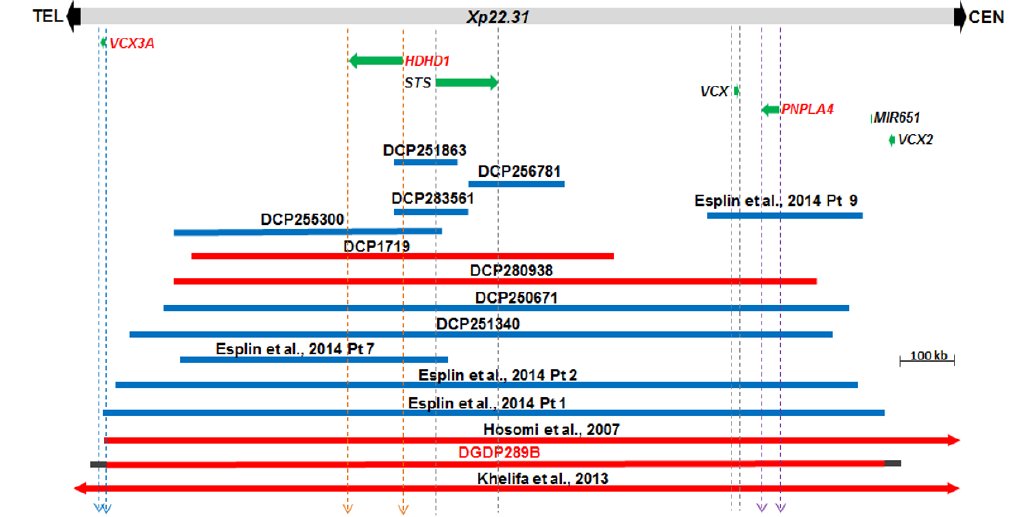
Figure 3. Comparative deletion mapping of CNVs at Xp22.31. The genes proximal and distal to STS are displayed. The microdeletion in our patient DGDP289B encompasses at least HDHD1 , STS , VCX , PNPLA4 and MIR651 . The distal breakpoint lies either within or in the immediate telomeric vicinity of VCX3A , while the proximal breakpoint resides around VCX2 . Three candidate genes, VCX3A , HDHD1 , and PNPLA4 , are in red letters. A total of eight additional cases were obtained from the DECIPHER (DCP) databases and are included above. Previously published cases include the microduplications in four patients reported in Esplin et al. and two additional microdeletions reported in Hosomi et al., and Ben Khelifa et al. [19,42,43]. Microdeletions are depicted by red bars, while microduplications are represented in blue. Gray horizontal bars at both ends of DGDP289B indicate the putative locations of the proximal and distal deletion breakpoints.